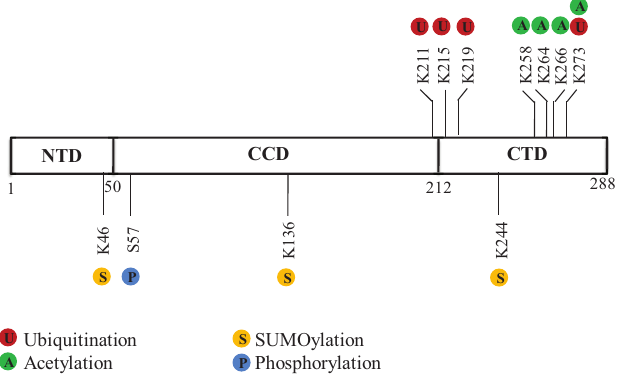
Figure 1. Sites of posttranslational modifications (PTMs) on HIV-1 integrase (IN). The schematic representation of the 288-amino acid domain structure of HIV-1 IN showing the amino acids subject to various PTMs, including ubiquitination, SUMOylation, acetylation and phosphorylation. Abbreviations: N-terminal domain (NTD); catalytic core domain (CCD); C-terminal domain